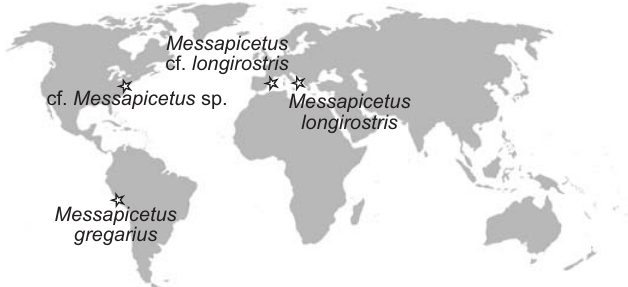
Fig. 11. Geographic distribution of fossil remains of Messapicetus from upper Miocene deposits worldwide (see text for data sources).